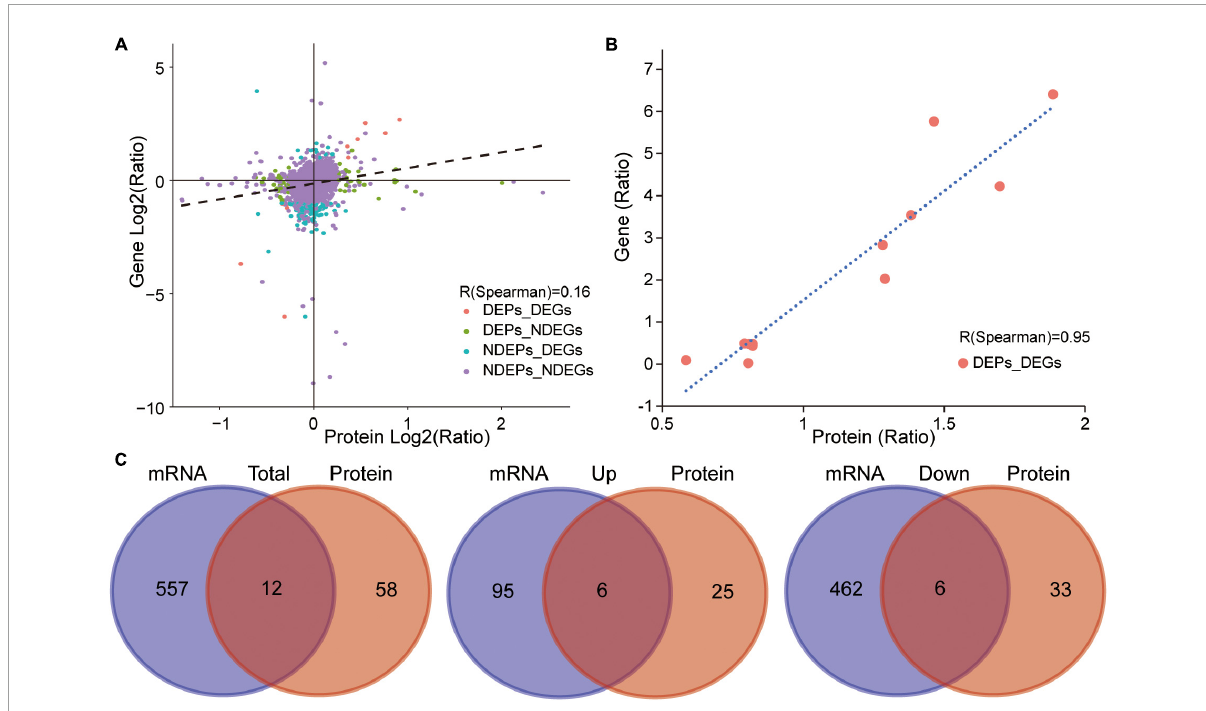
FIGURE6 Correlation between transcriptome and proteome. (A) Correlation analysis of transcriptome and proteome expression (TBSI vs. CTRL). (B) Correlation analysis of DEGs and DEPs (TBSI vs. CTRL). (C) Summary of overlapping DEG and DEP numbers in TBSI and CTRL groups (Left). Up-regulated overlapping DEG and DEP numbers (Middle). Down-regulated overlapping DEG and DEP numbers (Right).